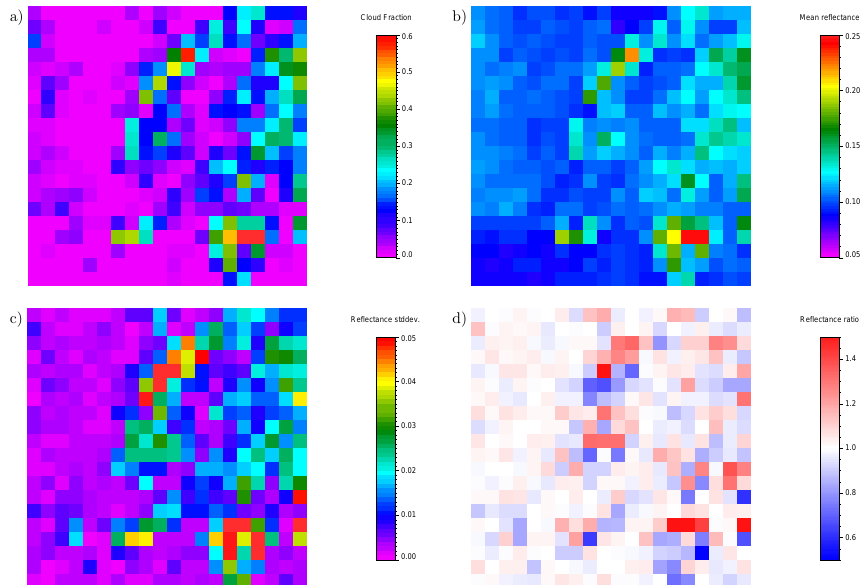
Fig. 3. Spatial distribution of reflectance quantities for the selected scene. Each square in the sub-figures correspond to one UVN ground pixel. (a) Cloud fraction (calculated as described in Sect. 2.2), (b) mean sub-pixel reflectances, (c) standard deviation of sub-pixel reflectances, (d) reflectance ratios (as defined in Eq. 1).